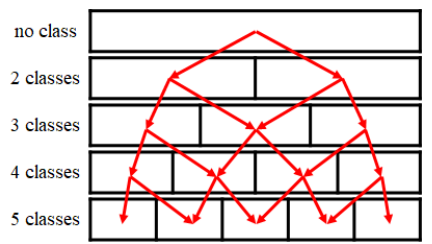
Figure 3. Successive refinement of classification.